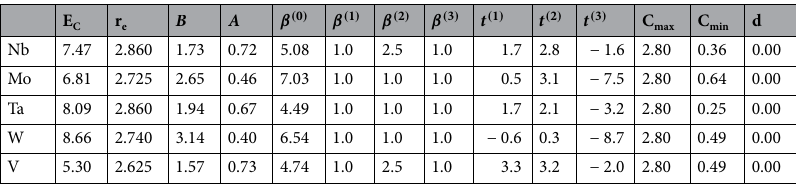
Table 1. The 2NN MEAM parameters for Nb, Mo, T, W, and V atoms.